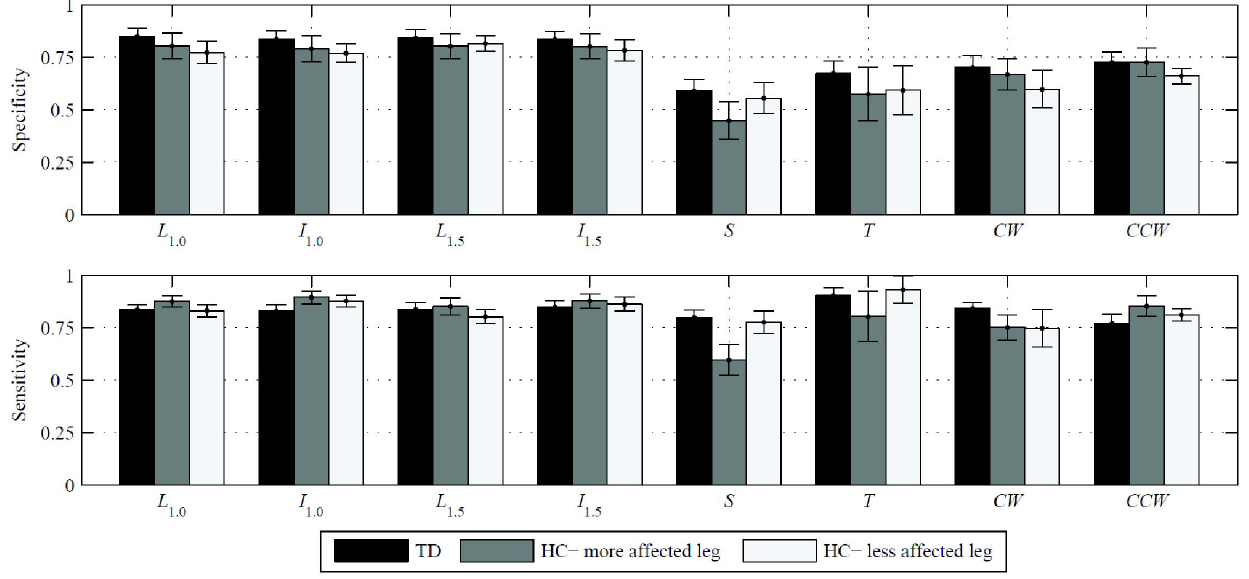
Figure 2. Specificity and sensitivity of A OL -detected gait phases, with FSR reference, for typically developing children and children with hemiplegia. The three populations are the combined legs of typically developing children (TD), the more affected legs of the children with hemiplegia (HC), and the less affected legs of the children with hemiplegia. Performance measures are given as mean 6 one standard error over each population. For patients with equally affected sides, the right is taken as the more affected leg.